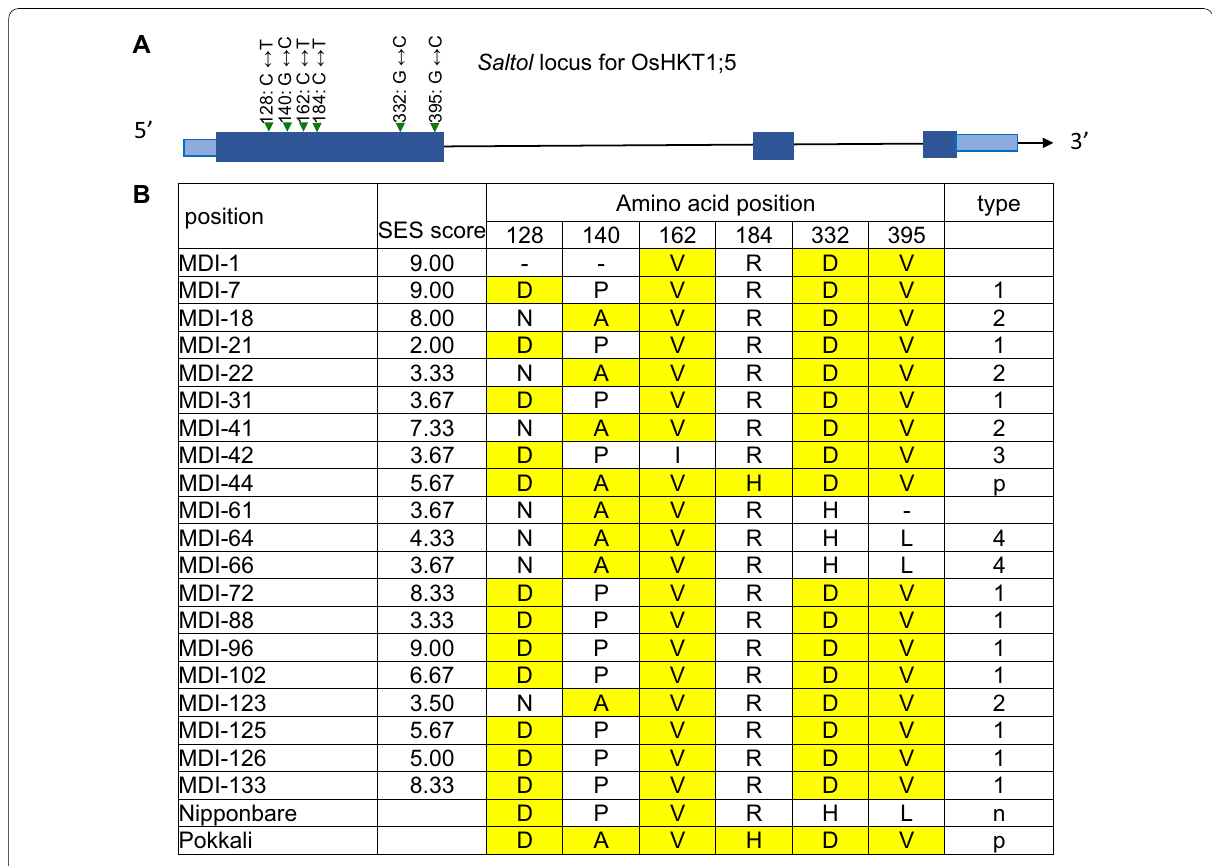
Fig. 4 Comparison of amino acid sequences between 20 MDI accessions and Nona Bokra/Pokkali at OsHKT1;5 encoded by the Saltol locus. A Schematic diagram of the OsHKT1;5 gene. Dark blue boxes, exons; light blue boxes, untranslated regions; lines, introns. The six positions of 20 MDI accessions indicate the polymorphisms leading to nonsynonymous amino acid (aa) changes relative to the Saltol allele of the Nona Bokra/Pokkali accessions. B Haplotype analysis of nonsynonymous amino acid substitutions at the six sites defined above in each of the 20 MDI accessions. Yellow and ( ) represent shared amino acids with Nona Bokra/Pokkali and undetermined amino −